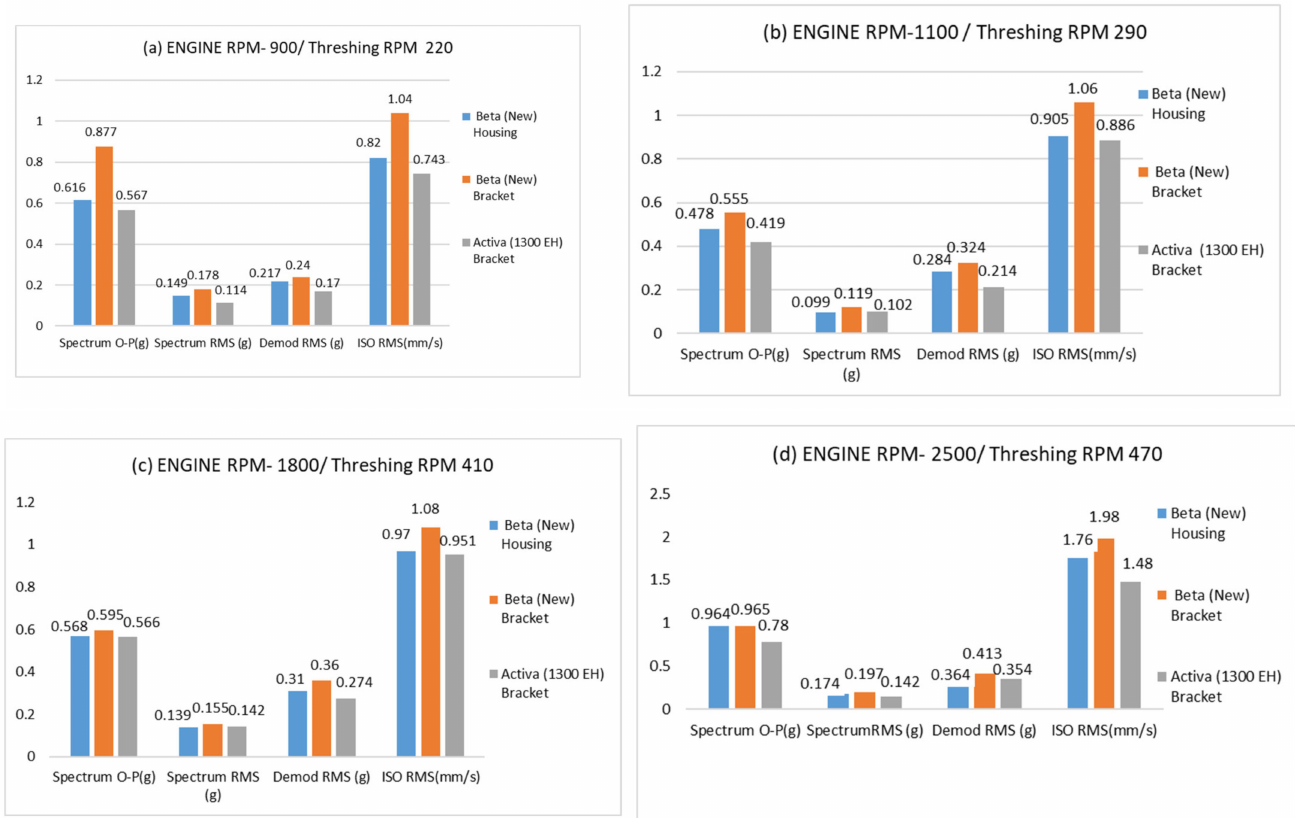
Figure 10. Comparison of the vibration parameters values when the sensor is mounted on bracket and the housing of Beta and Activa versions at different threshing rotating speeds: ( a ) Threshing drum rotating at 220 RPM; ( b ) Threshing drum rotating at 290 RPM; ( c ) Threshing drum rotating at 410 RPM; and ( d ) Threshing drum rotating at 470